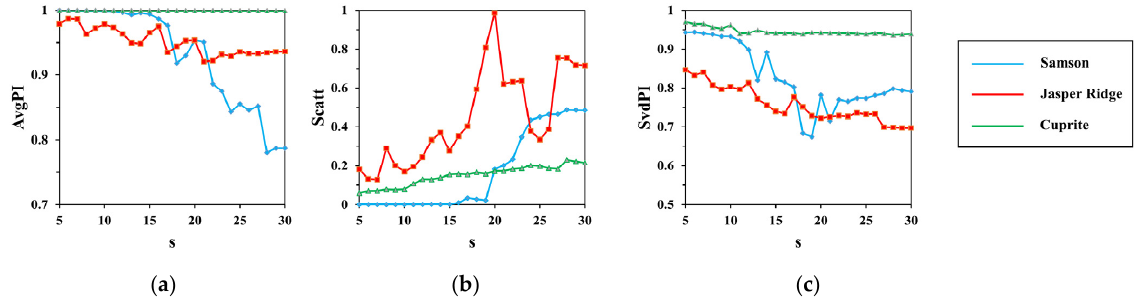
Figure 5. The results of ( a ) Scatt; ( b ) AvgPI; ( c ) SvdPI with the change of s.